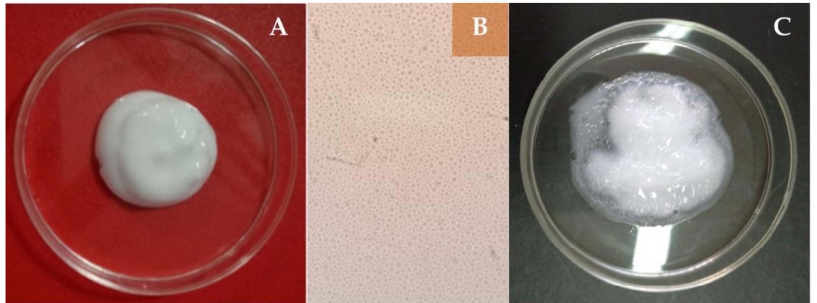
Figure 2. ( A ) Optical image of a typical I-series HIPE; ( B ) optical micrographs (40 × ) of HIPE in the presence of the Sudan Red G; and ( C ) optical image of I-series polyHIPE from UV crosslinking.